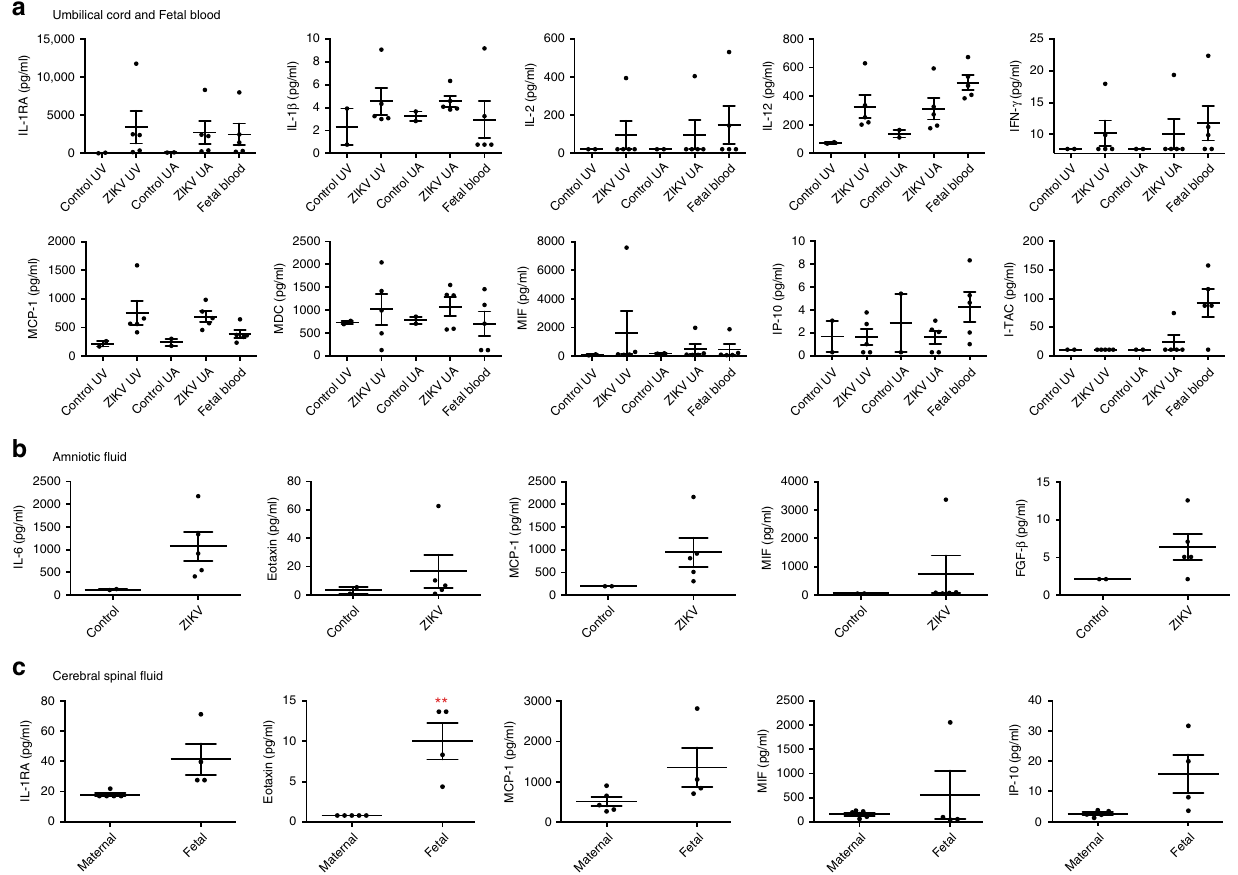
Fig. 3 Cytokine and chemokine pro fi ling. A 29-plex-cytokine magnetic bead assay was performed on a plasma isolated from ZIKV-infected and control fetal and cord blood, b amniotic fl uid; and c fetal and maternal cerebral spinal fl uid at 135dGA. Plasma analysis revealed changes in the cytokines IL-RA, IL-1 β , IL- 2, IL-12, IFN γ , and MIF; and chemokines MCP-1 (CCL-2), MDC (CCL-22), IP-10 (CXCL-10), and ITAC (CXCL-11). Compared to controls increased levels of IL-6, Eotaxin (CCL-11), MCP-1 (CCL-2), MIF and FGF-basic were detected in amniotic fl uid from infected animals. Levels of IL-1RA, Eotaxin (CCL-11), MCP-1 (CCL-2), MIF, and IP-10 (CXCL-10) were higher in fetal vs. maternal CSF. One-way ANOVA was performed with Tukey ’ s multiple comparison test, bars represent mean and SEM, ** p < 0.01, * p < 0.05 UV, umbilical vein; UC, umbilical cytometric antibody panels speci fi c for innate and T-cell subsets. The frequency of activated innate immune cells (monocytes/ macrophages and DCs) was higher in placental tissues from ZIKV-infected dams vs. control dams (Fig. 2a, b, d). There was a signi fi cant increase in the percent of activated (CD169 + ) mono- cyte/macrophages from ZIKV-infected placenta tissues compared to uninfected controls in both the decidua ( p < 0.01, one-way ANOVA) and villous ( p < 0.05, one-way ANOVA). The mono- cyte population was further divided into three functionally dif- ferent subsets based on CD14 and CD16 expression: classical (CD14 hi CD16 − ), intermediate (CD14 hi CD16 + ), and non-classical (CD14 lo CD16 + ) monocytes. Surprisingly, the ratio of classical to non-classical monocytes was decreased in both decidua and vil- lous from ZIKV-infected dams compared to uninfected controls (Fig. 2c). Classical monocytes are involved in wound healing, antigen presentation, and typically secrete IL-10, while non- classical monocytes actively patrol tissues following damage and secrete in fl ammatory cytokines (IFN- γ , TNF- α , IL-1 β , and IL- 12) 39 . Staining of placenta tissues for macrophage subtypes via CD68 (M1) and CD163 (M2) showed both populations were present, with an increase in M1 macrophages in the villous stroma during ZIKV infection (Supplementary Fig. 5). Pro- liferation of CD4 T cells was also increased in placenta tissues from ZIKV-infected dams compared to uninfected controls.